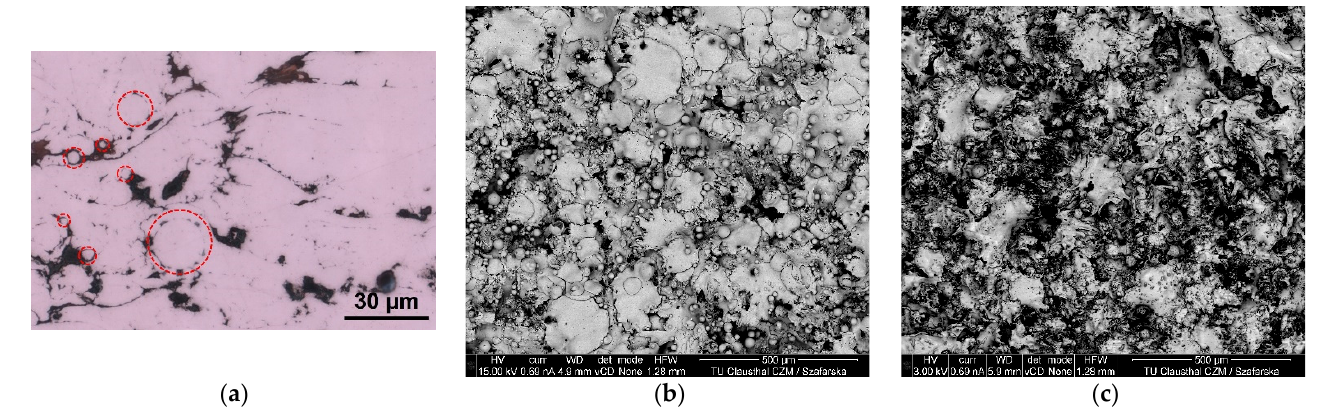
Figure 6. Trapped micro particles ( a ) in a copper coating and ( b ) on the copper coating surface when produced in an oxygen-free environment; ( c ) coating surface of a conventional copper coating.